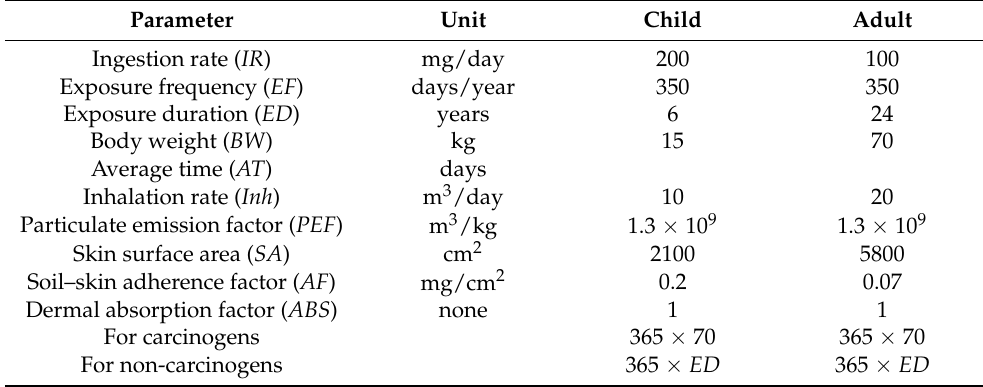
Table 3. Parameters used in risk